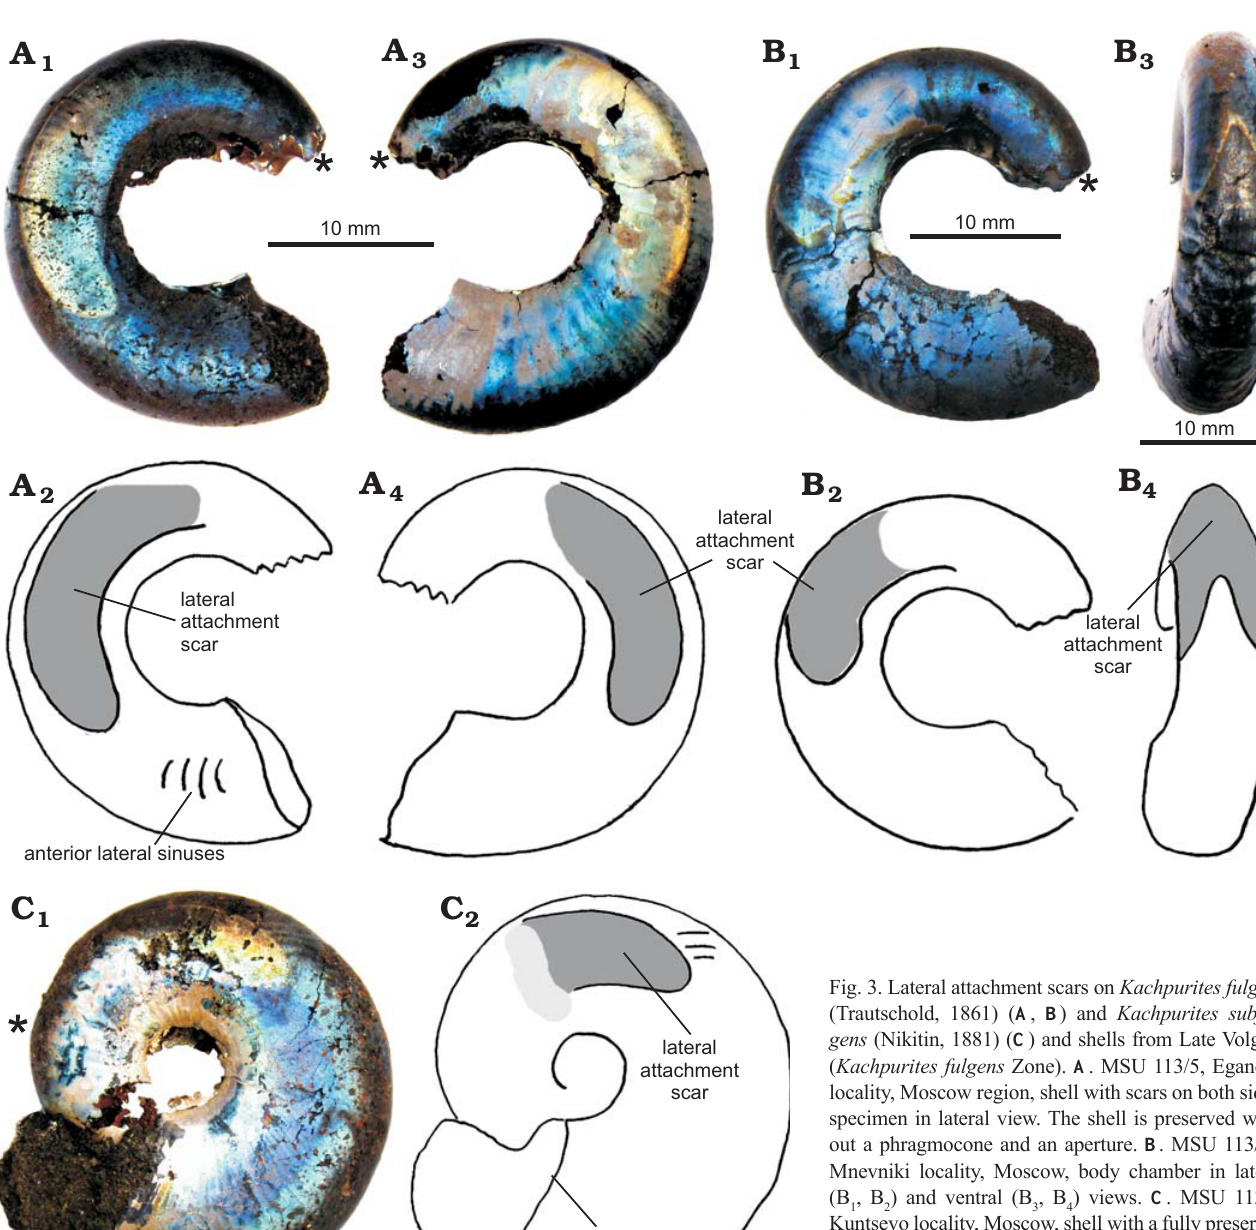
Fig. 3. Lateral attachment scars on Kachpurites ful gens (Trautschold, 1861) ( A , B ) and Kachpurites subful- gens (Nikitin, 1881) ( C ) and shells from Late Volgian ( Kachpurites fulgens Zone). A . MSU 113/5, Eganovo locality, Moscow region, shell with scars on both sides, specimen in lateral view. The shell is preserved with- out a phragmocone and an aperture. B . MSU 113/14, Mnevniki locality, Moscow, body chamber in lateral (B , B ) and ventral (B , B ) views. C . MSU 113/4, 1 2 3 4 Kuntsevo locality, Moscow, shell with a fully preserved body chamber and an aperture. Asterisks mark the base of the body chamber. Photographs (A , A , B , B , C ) 1 3 1 3 1 and explanatory drawings (A , A , B , B , C 2 4 2 4 2